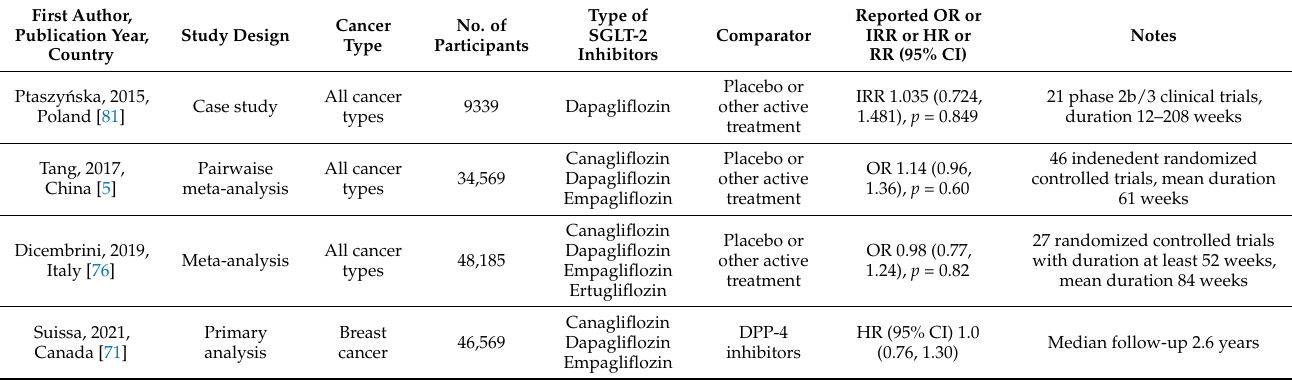
Table 1. Summary of clinical trials assessing the cancer risk associated with SGLT-2 inhibitor